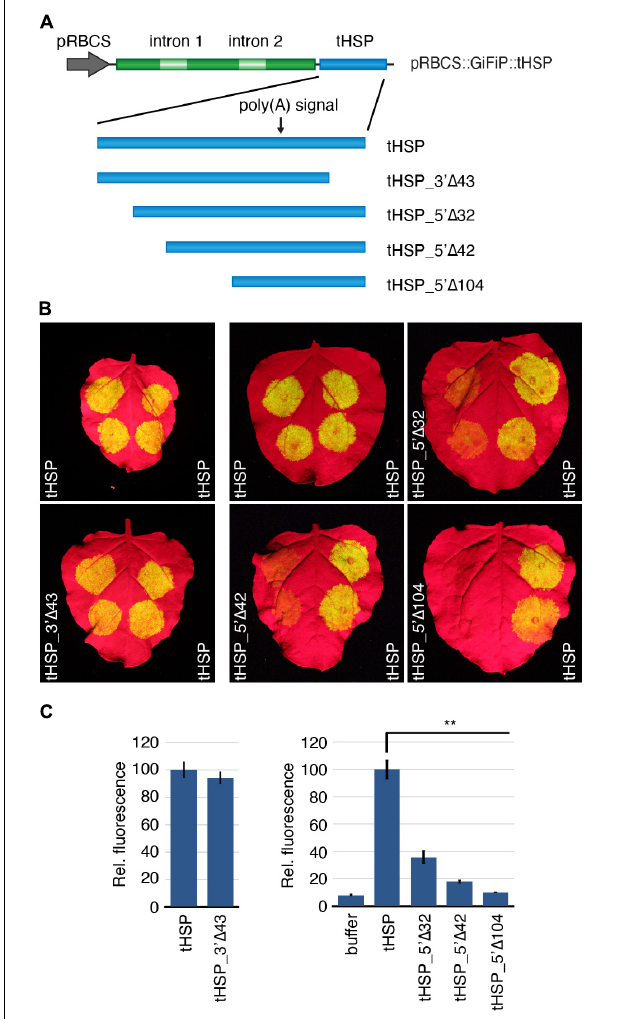
FIGURE 2 | Deletion analysis to assess the effect of different regions of the tHSP on the terminator activity. (A) Representation of the pRBCS::GiFiP reporter using the wild-type tHSP or different versions containing deletions of specific regions. (B) Nicotiana benthamiana leaves agroinfiltrated with the different constructs. Leaves were infiltrated with the test sample (left side) and the wild-type terminator (right side) as reference. Infiltrations for 5 (cid:48) and 3 (cid:48) end mutants were carried out in independent experiments and hence, shown separately. (C) GFP fluorescence for deletions affecting the 5 (cid:48) end of the terminator was calculated from five infiltration spots (originating from four leaves, each from a different plant). Values referent to the 3 (cid:48) end mutations are from 10 infiltration spots coming from five leaves, each leaf from an independent plant. All values are relative to the wild-type tHSP. Standard error bars are given. Statistically significant differences between the wild-type and each of the mutants (Mann-Whitney U test) are indicated by “**” ( p ≤ 0.01).